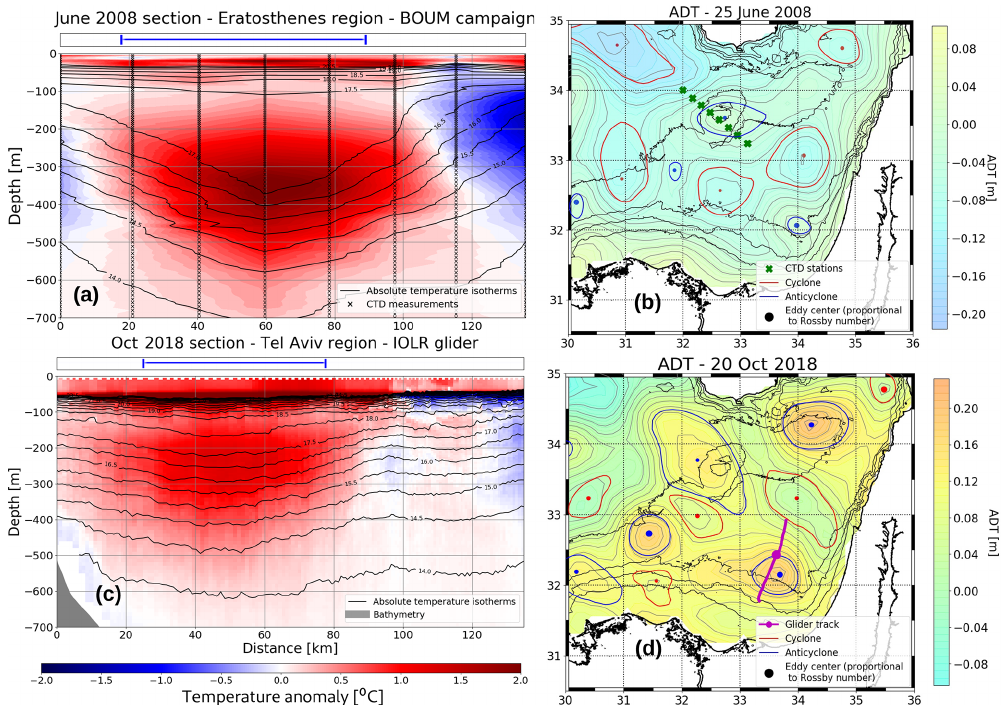
Figure 12. Comparison of anticyclone sections. The Eratosthenes ( a ) and Tel Aviv ( c ) region anticyclone sections in June 2008 and mid- October 2018, respectively. The left side is northwards, the horizontal axis (shared) is the distance along the section, black lines are the absolute temperature isotherms, the temperature anomaly is shown using the colored background and the blue cartridge above the panel outlines the limits of the eddy contours. Panels ( b ) and ( d ) show the respective ADT maps at the corresponding date of cast, presenting the neighboring eddy activity. Green crosses (a magenta line) show the CTD casts (the glider track). The eddy contours are maximal speed contours – blue denotes the anticyclones, red denotes cyclones and there is a Rossby number-scaled dot for their